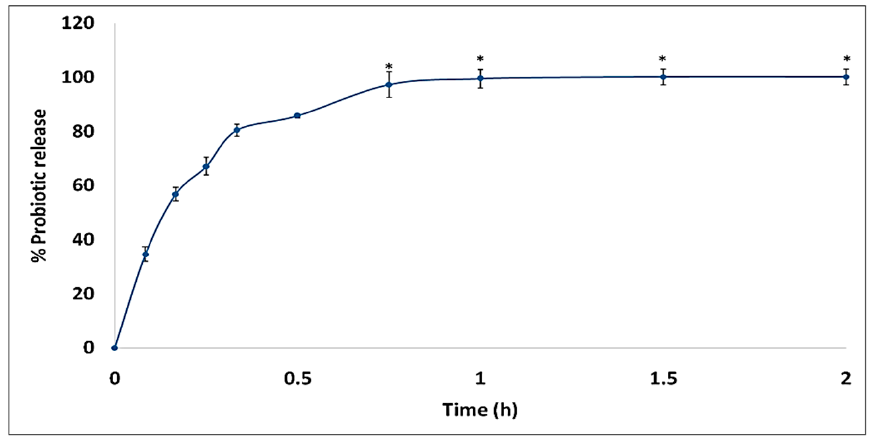
Figure 3. In vitro release profile of probiotic from gelatin–oil suppositories. All values differ signif- icantly except those marked similarly.